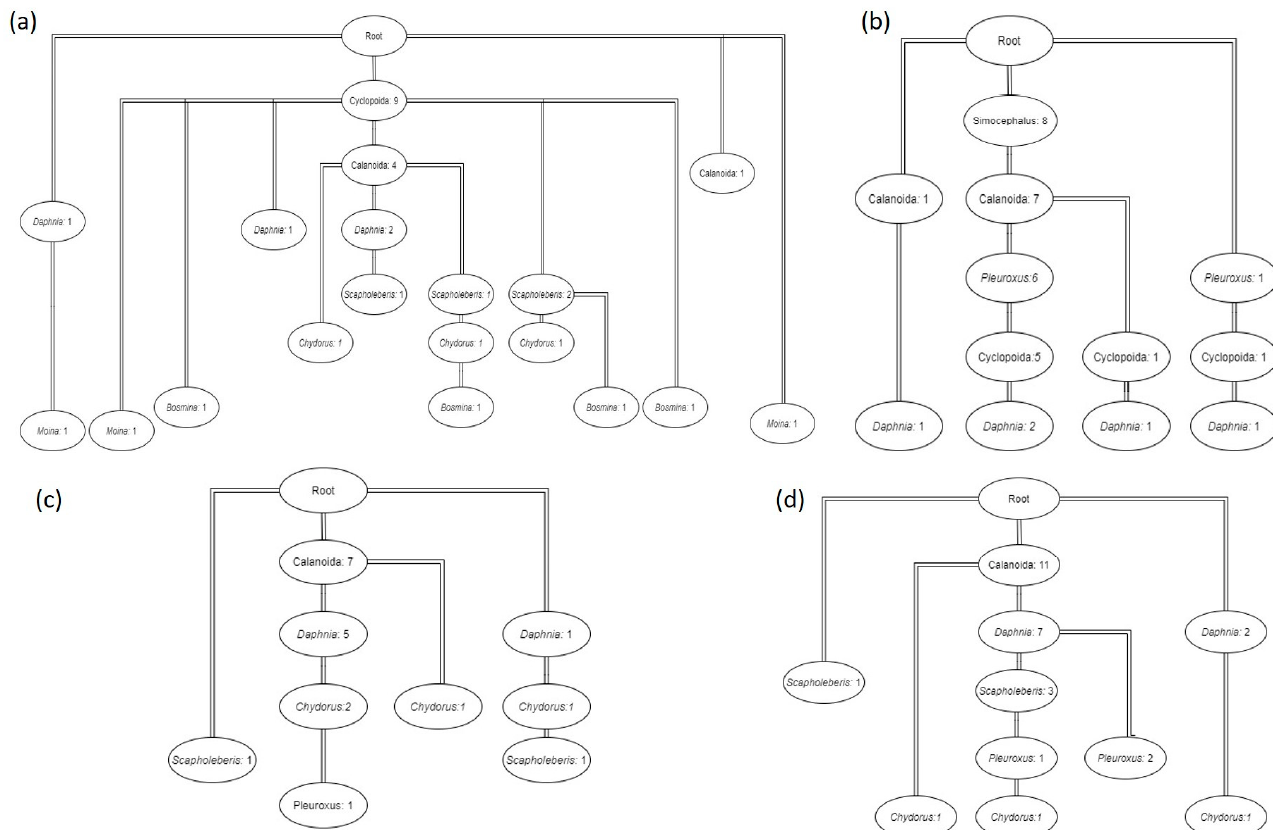
Figure 7. Frequent pattern trees (FPt) for the community structure in Cluster 1 ( a ) and 2 ( b ) in 2014 and in Cluster 1 ( c ) and 2 ( d ) in 2015. Each node represents a specific taxon and its absolute frequency (number of ponds where the taxon was found). The branches join the co-occurrence of taxa. Only the taxa with frequency > 20% were reported (see also Figure S4).